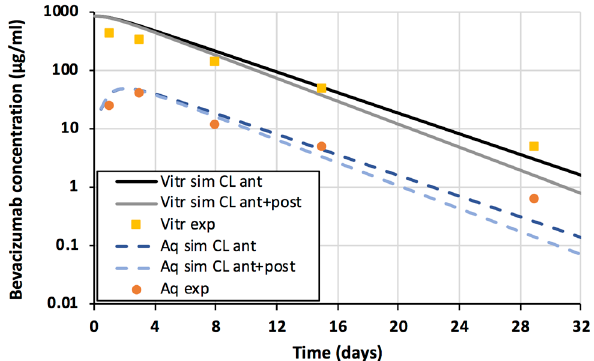
Figure 3. Experimental (symbols) and simulated (lines) bevacizumab concentrations in the vitreous (yellow squares) and aqueous humor (orange spheres). The simulated vitreal and aqueous humor concentrations with only anterior clearance are shown as a black solid line and a dark blue dashed line, respectively. The simulated vitreal and aqueous humor concentrations with anterior and posterior clearance are shown as a grey solid line and a light blue dashed line, respectively.